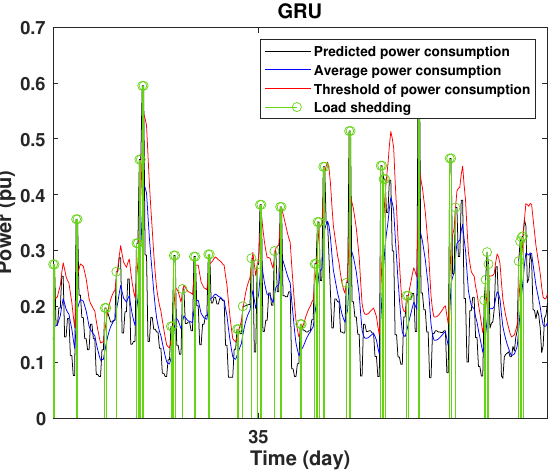
Figure 24. Detection of power consumption peaks during 3 days using the GRU model.